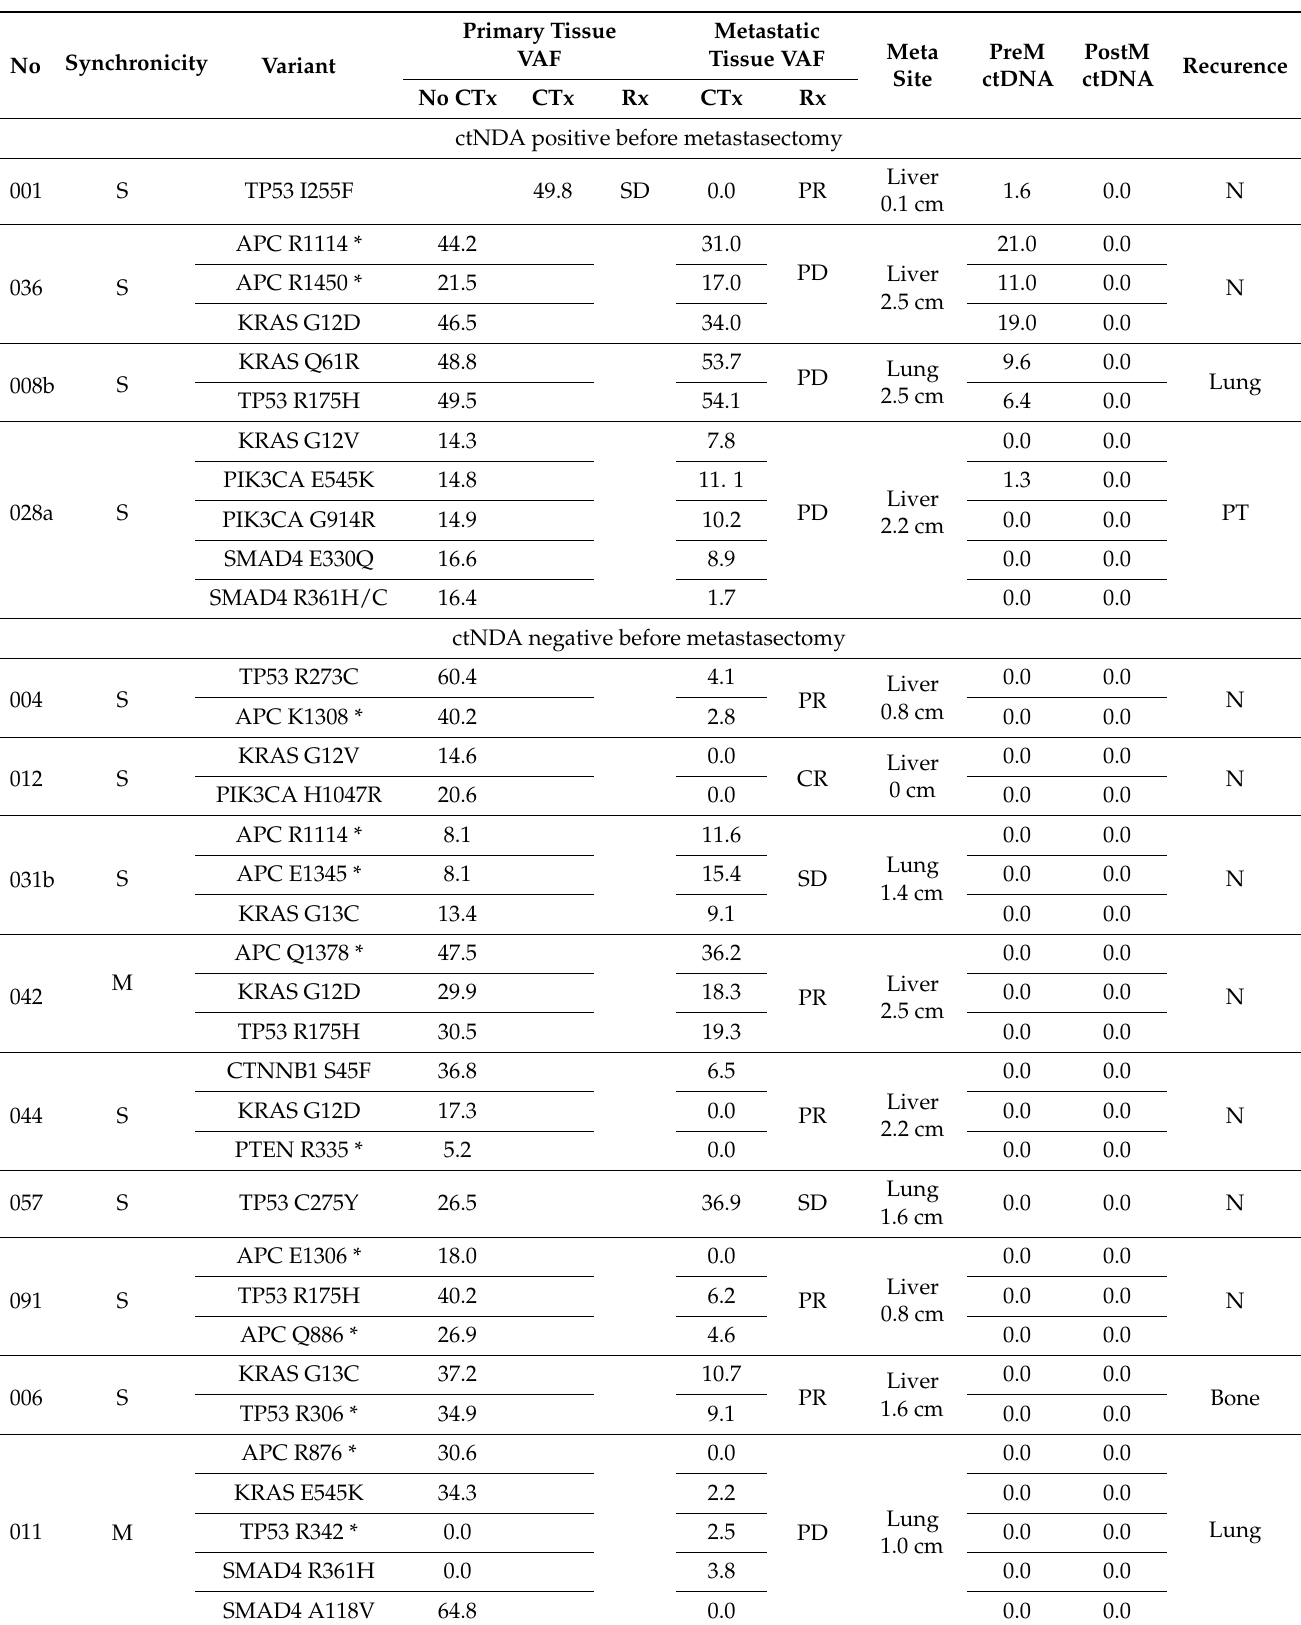
Table 4. Neoadjuvant Chemotherapy Followed by Metastasectomy (R0 resection) ( N event =